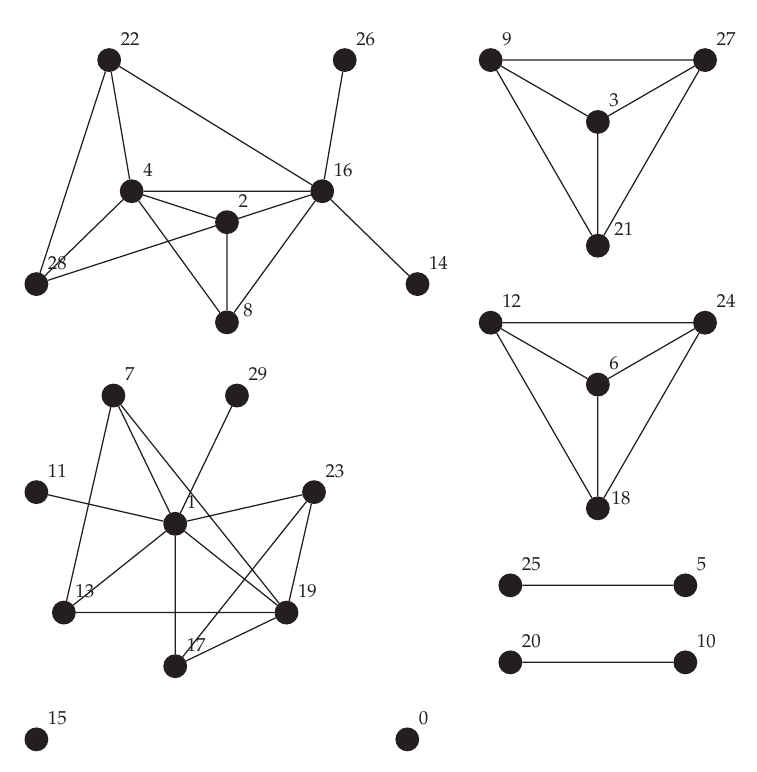
Figure 1: The simple graph of G (cid:2) 30 (cid:3)